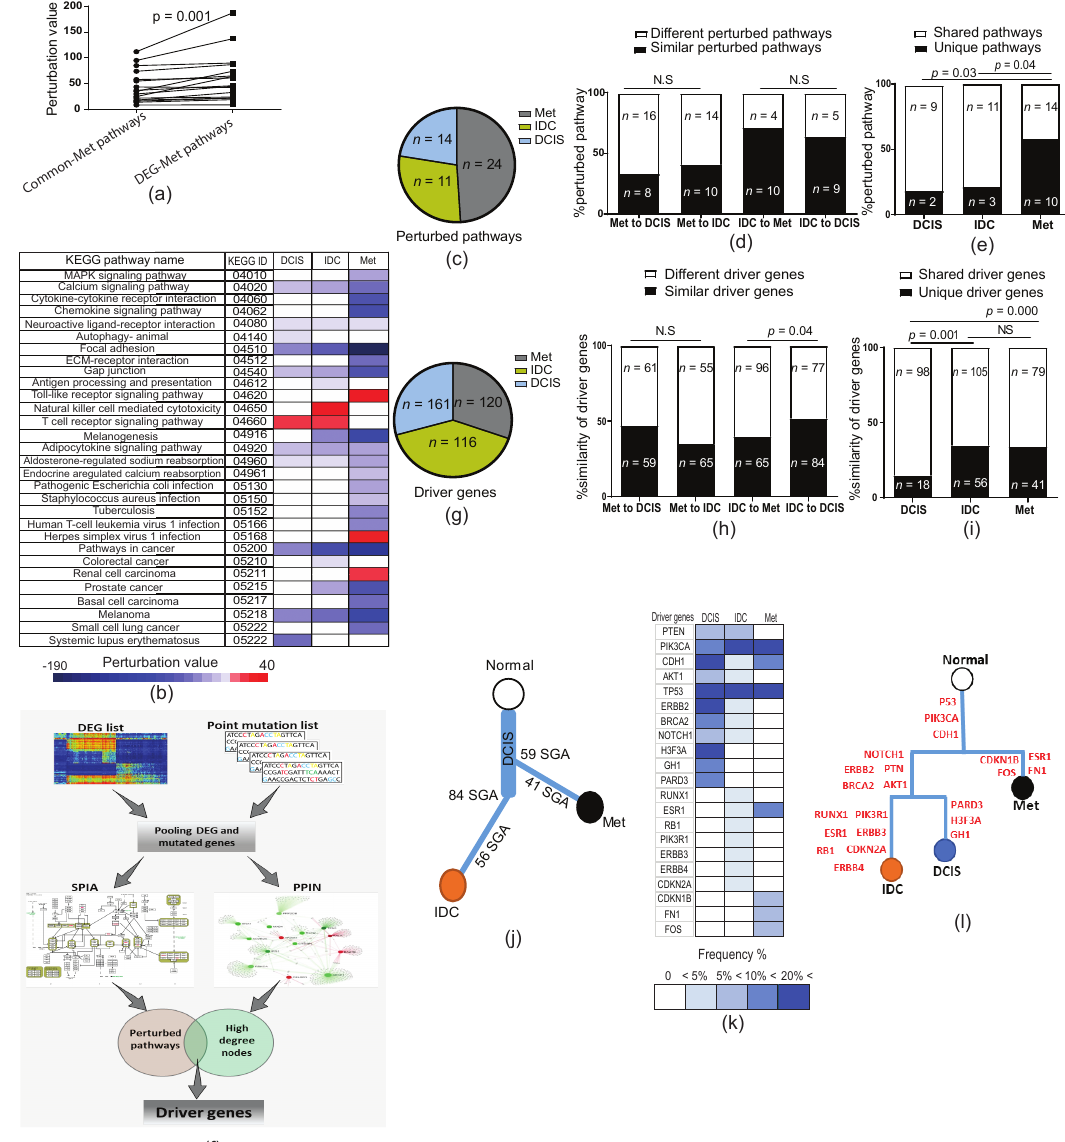
Figure 6. Evolution of metastasis and divergence time from primary tumor. ( a ) Evaluation of perturbation between common–Met SGAs and all DEG–Met SGAs; ( b ) heatmap of perturbed pathways obtained by SPIA analysis for DCIS, IDC, and Met; ( c ) pie chart presenting the number of perturbed pathways in each group; ( d ) similarity of perturbed pathways shown between the DCS, IDC, and Met groups (Table S9); ( e ) comparison of the number of unique and shared perturbed pathways for each group. A shared perturbed pathway is one that exists at least in two groups. ( f ) A demonstration of our modified version of DawnRank for the detection of driver genes (see Section 4.8); ( g ) a pie chart presenting the number of driver genes in each group; ( h ) the similarity of driver genes between the DCS, IDC, and Met groups; ( i ) comparison of the number of unique and shared driver genes for each group. A shared driver gene is the one that exists at least in two groups. ( j ) Conceptual phylogenetic tree extracted from ( d , e , h , i ); ( k ) heatmap of mutated driver genes shared between DCIS, IDC, and Met (see Table S10 and Figure S6b); ( l ) phylogenetic tree constructed based on the mutation profile of shared driver genes between DCIS, IDC, and Met, presented in ( k ). The valuation p -values in ( a ) were calculated by a paired Student’s t -test; those in ( d , e ) were calculated by Fisher’s exact probability test; and those in ( h , i ) were calculated by a chi-square